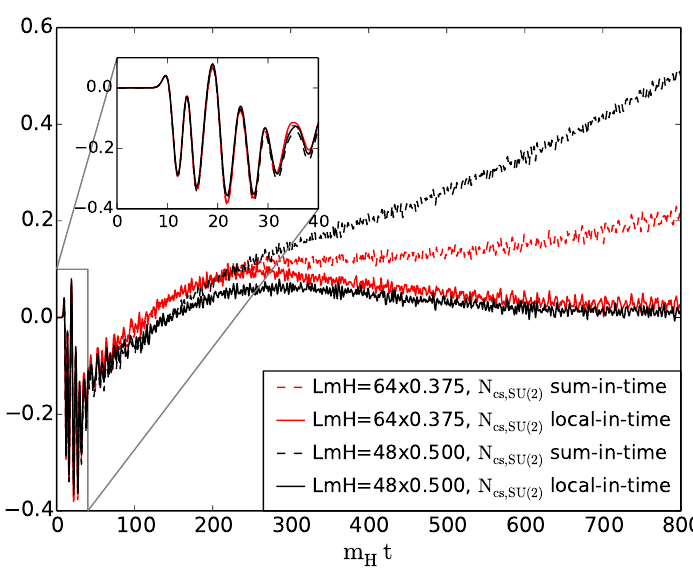
Figure 9 . The two lattice de(cid:12)nitions of N , for two lattice spacings, with the same physical cs ; SU(2) volume. The local-in-time de(cid:12)nition performs best and is less lattice spacing